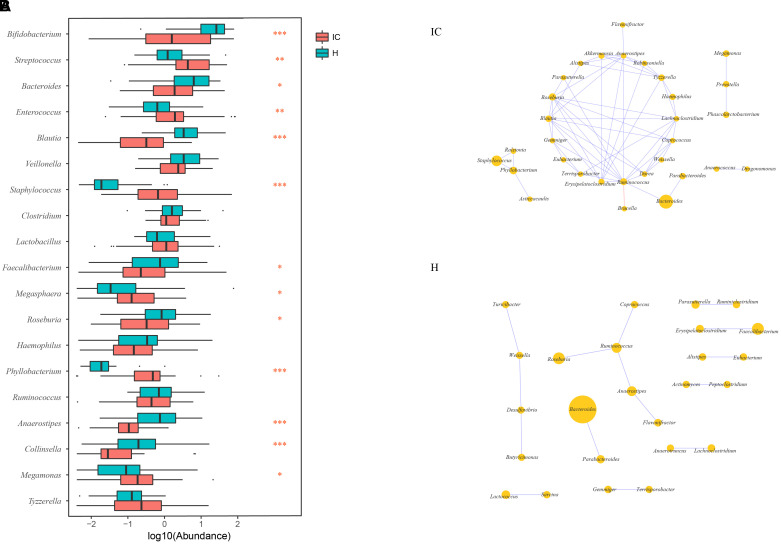
Discrepancy in GM components and networks between the IC and H groups. (A) A total of 13 taxa are differentially enriched between the IC and H groups. Streptococcus, Enterococcus, Staphylococcus, Megasphaera, Phyllobacterium, and Megamonas are enriched in the IC infants, whereas the numbers of Bifidobacterium, Bacteroides, Blautia, Faecalibacterium, Roseburia, Anaerostipes, and Collinsella are lower than those in the H group. One, two, and three asterisks stand for the P-value lesser than 0.05, 0.01, and 0.001, respectively. (B) The GM co-occurrence network was constructed for the IC and H groups, respectively. The purple and red edges stand for the positive and negative correlations, respectively. The diameter of the circle is proportional to the relative abundance. The bacterial network in the IC group is more complicated than that in the H group, and some correlations in the H group are disrupted.